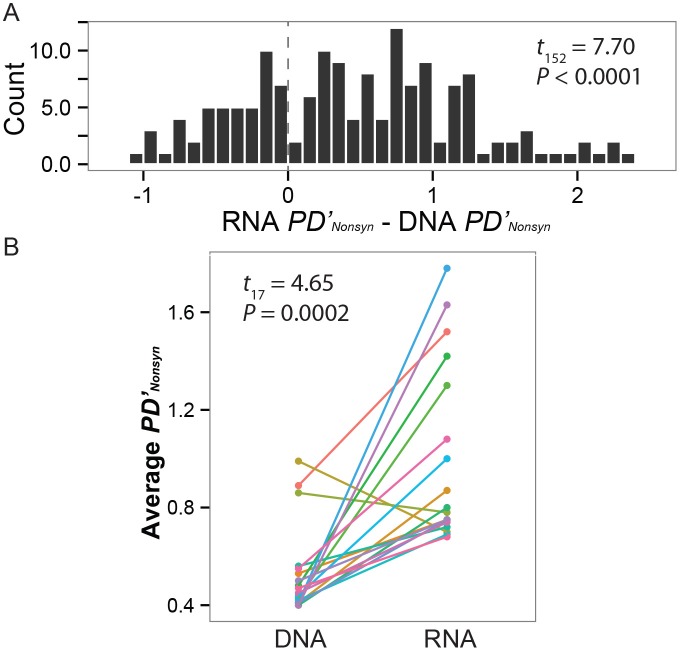
Variable expression of paralogs increases individuality.(A) The pairwise difference in non-synonymous sites, which would alter an individual’s protein complement, is higher in RNA than DNA. Values below 0 indicate that a pair of individuals is more similar at the level of RNA than DNA. Conversely, values above 0 indicate that individuals are more different as a result of differential transcription of Mup sequences. (B) A significant majority of mice experience an overall increase in individuality as a result of differential transcription.